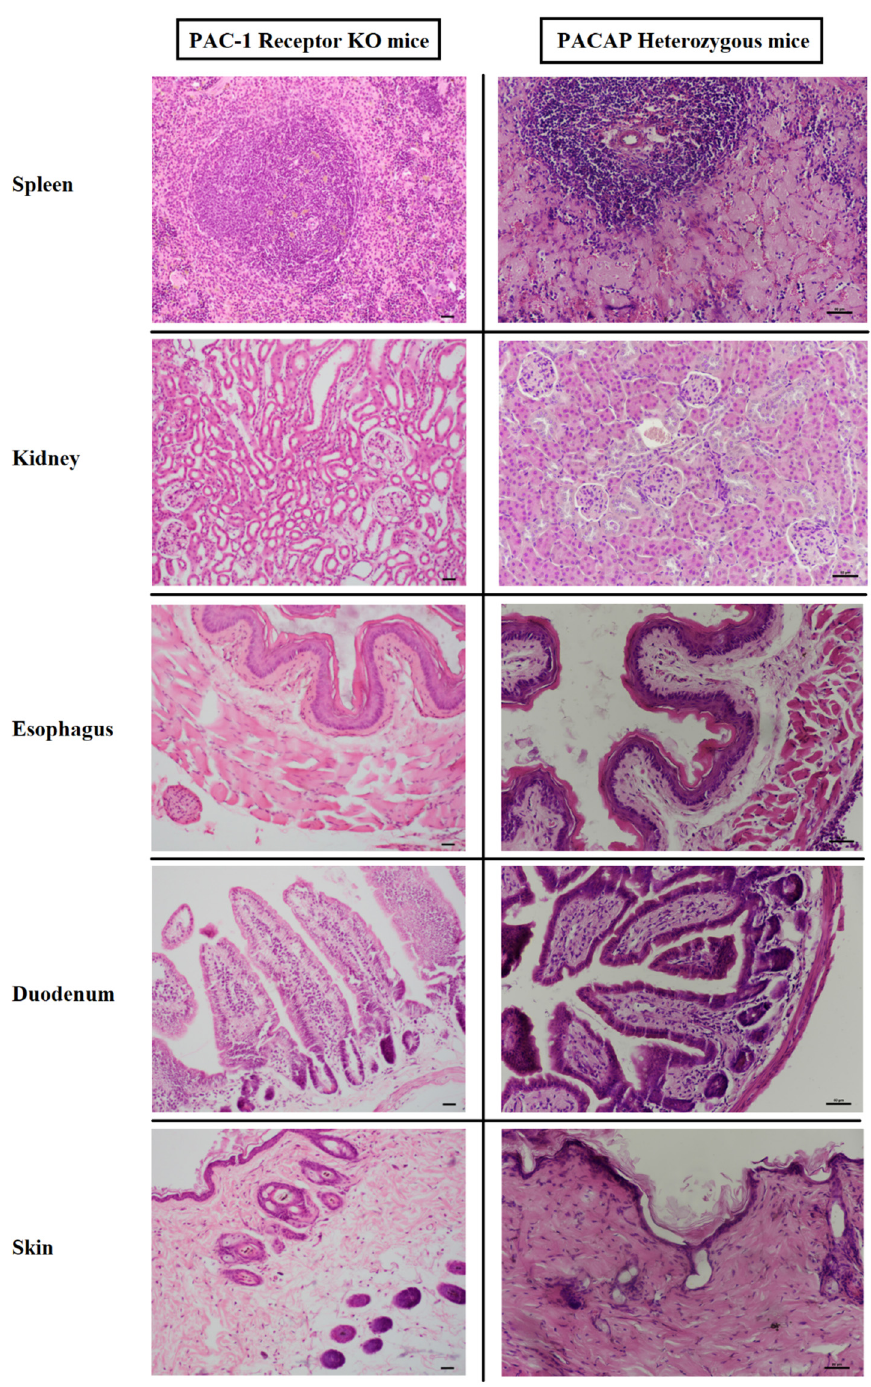
Figure 1. Representative photomicrographs of amyloid deposits in tissues from PAC1 receptor KO mice ( left side) and from PACAP HZ mice ( right side). Representative pictures from spleen, kidney, esophagus, duodenum, and skin are shown with HE staining. No amyloid deposits were found in receptor KO mice, while PACAP HZ mice showed severe deposits in the spleen parenchyme, in the renal corpuscles, in the lamina propria of esophagus and intestines, and in the subepidermal layer of the skin. Scale bar: 50 micrometers.